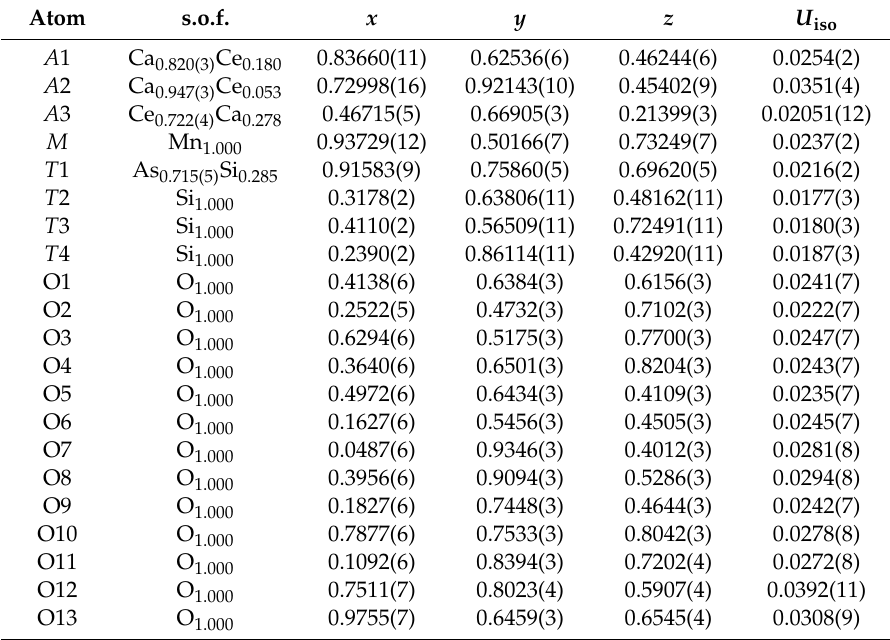
Table 6. Atoms, site-occupancy factors (s.o.f.) and fractional atomic coordinates of kesebolite-(Ce).